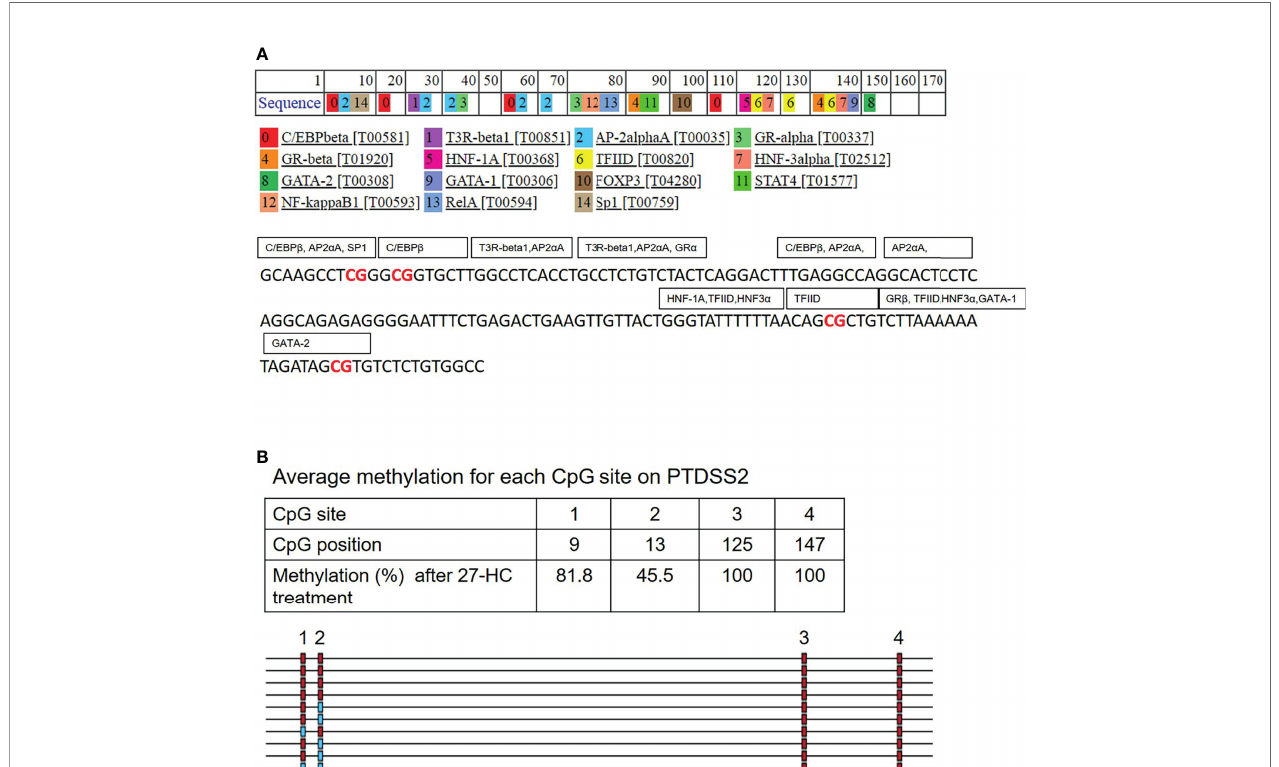
FIGURE 6 | In silico analysis for transcription factor (TF) binding sites on PTDSS2 promoter: (A) The list of predicted TFs for PTDSS2 promoter sequence. The TFs are labeled in the box covering its putative binding sites on the promoter DNA sequence. The hypermethylated CpG sites are highlighted in red. (B) The output fi le from bisul fi te sequencing analysis for PTDSS2 gene promoter using BIMSA software and indicates the percentage of methylation at the top 4 CpG sites in the 27- hydroxycholesterol (27-HC)-treated